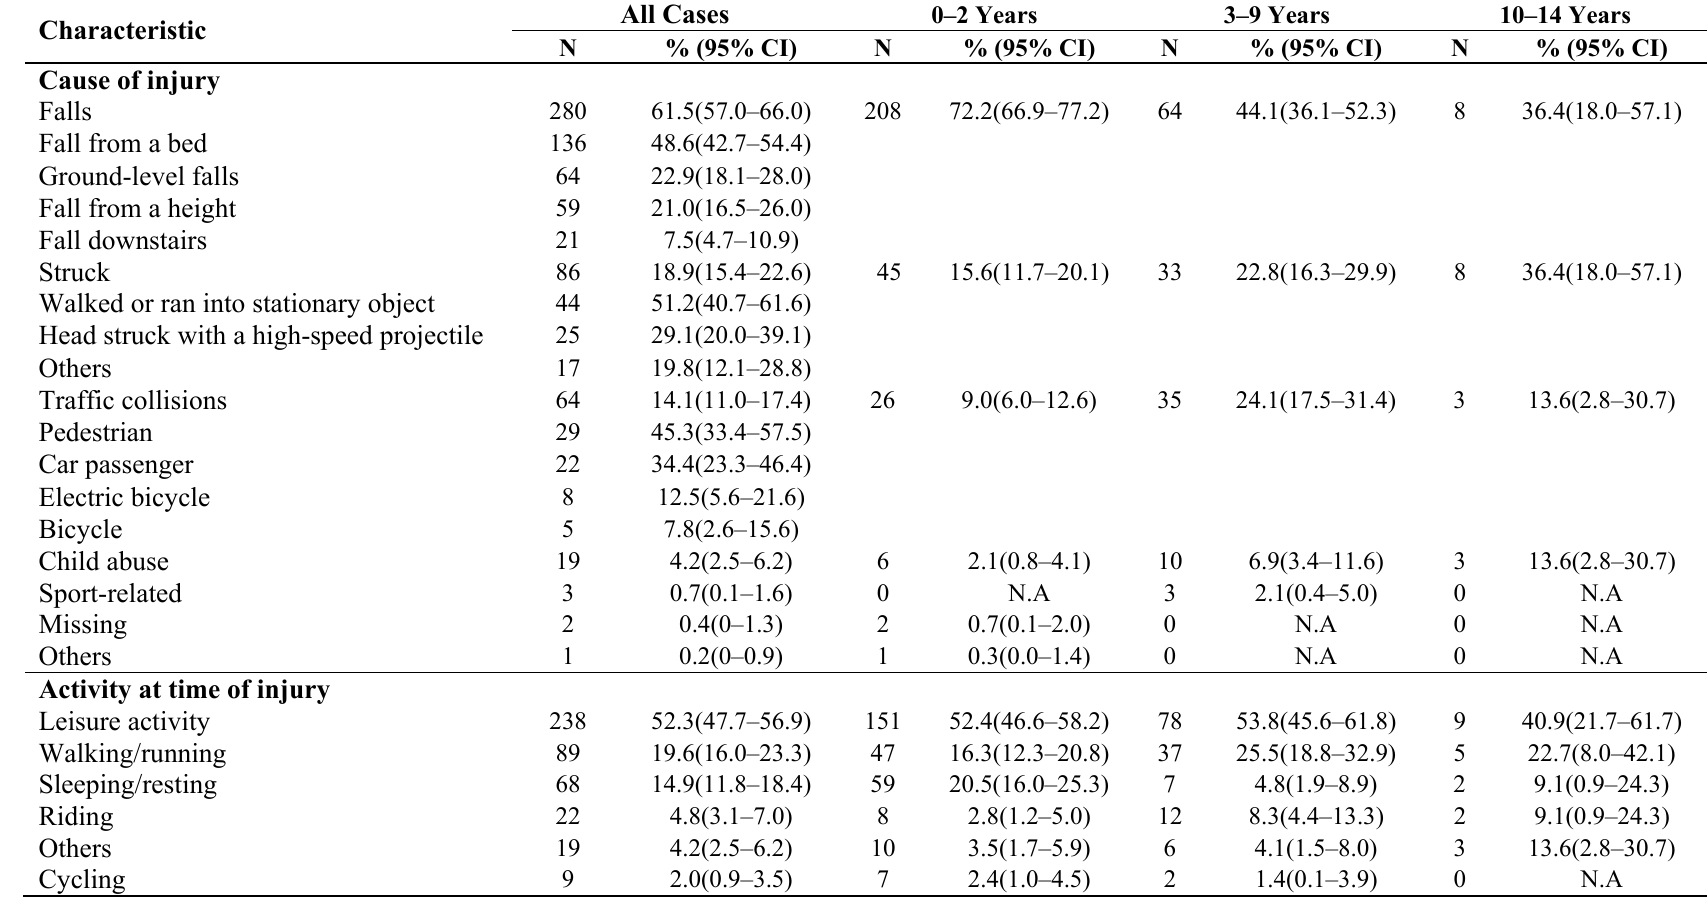
Table 1. Characteristics of injuries in sampled 455 children with